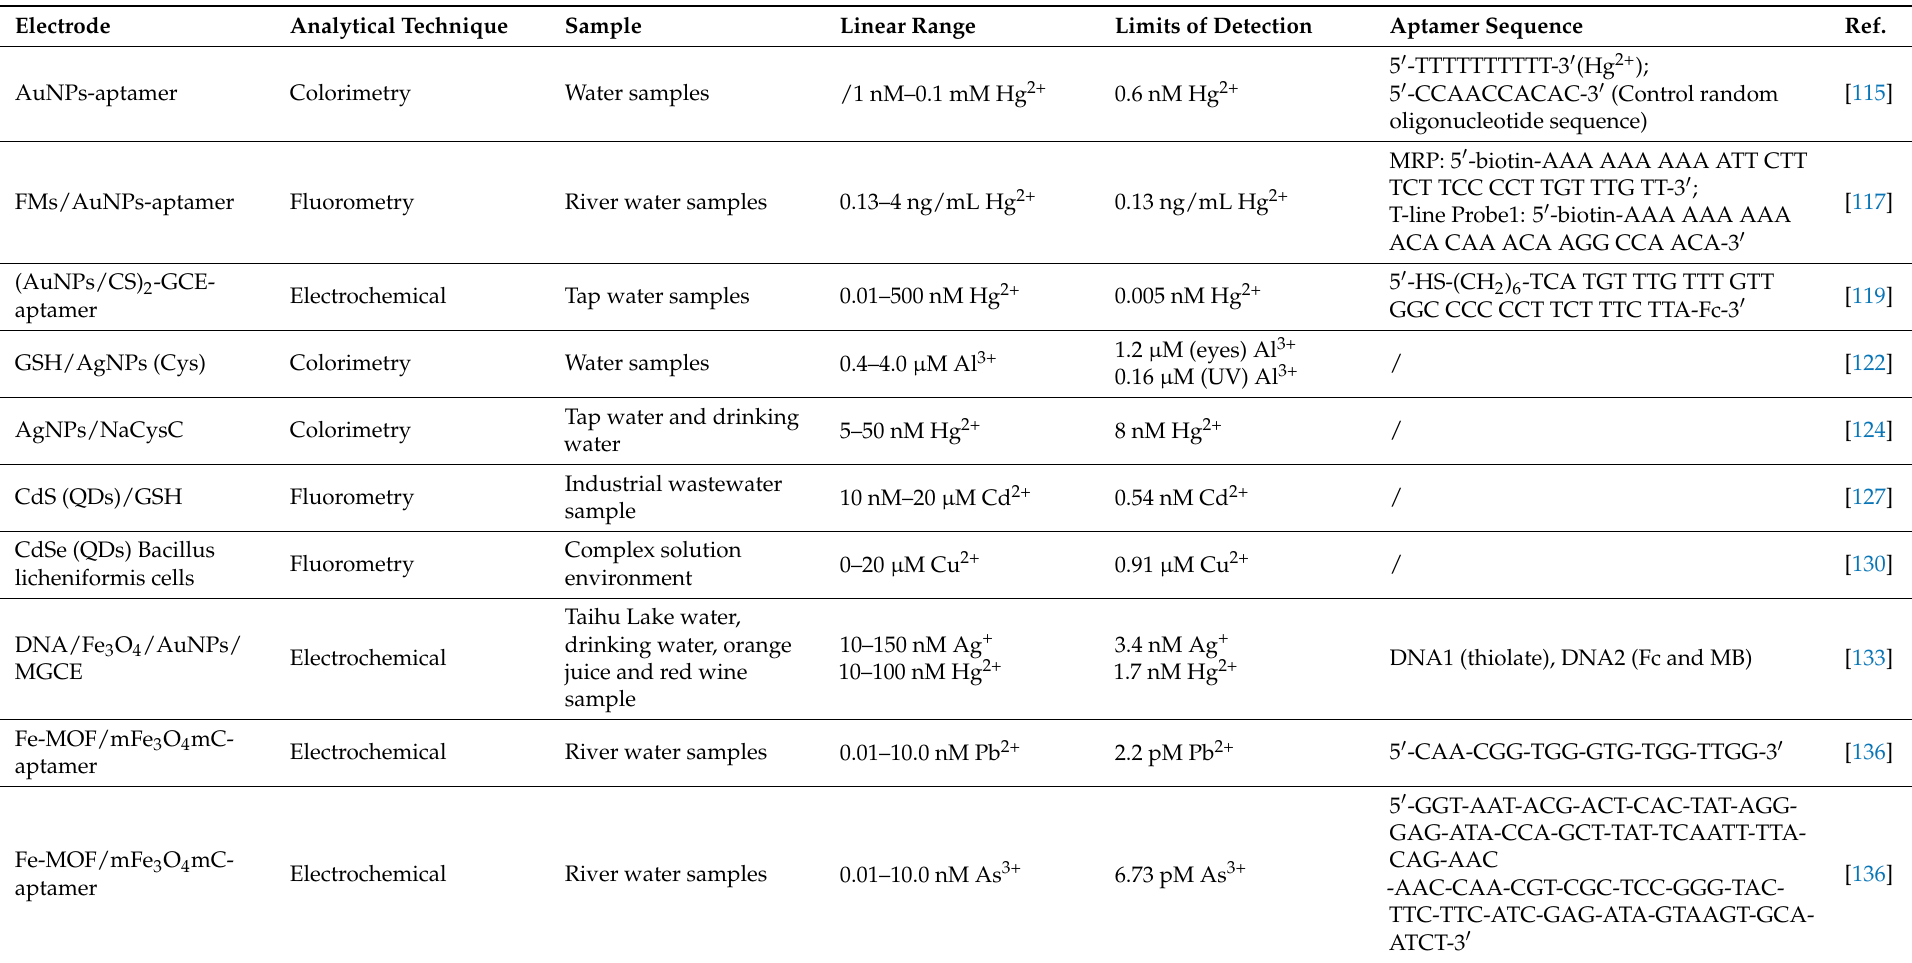
Table 5. Representative studies of probed-based detection of heavy metals from food and water resources by